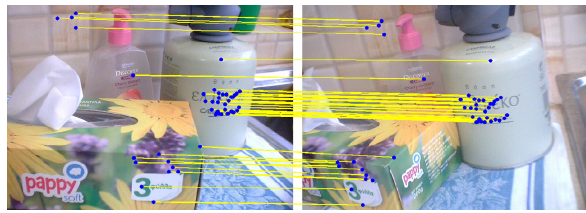
Figure 2. The stereo-pair of the auxiliary 3D scene and all SIFT point matches involved in the computation of the fundamental matrix using the RANSAC algorithm.